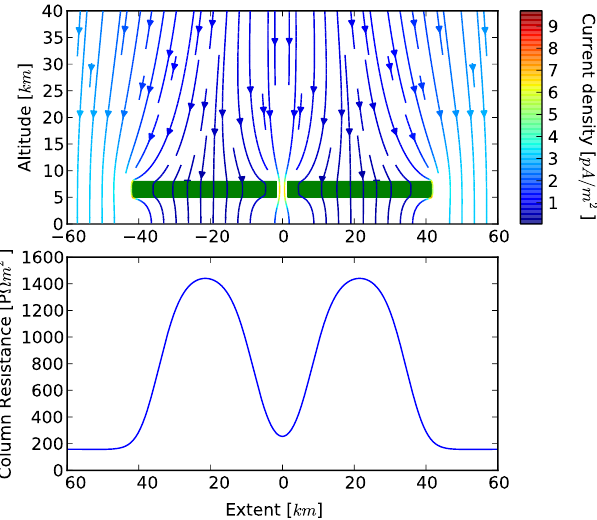
Figure 8. Top: current streamlines in the vicinity of two clouds that are separated by 3km. Bottom: corresponding column resistance b R col